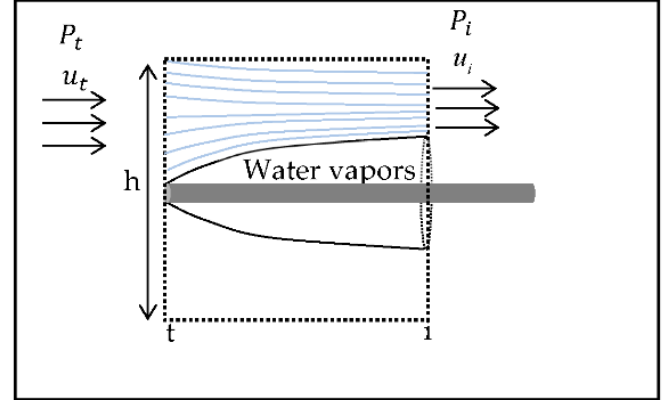
where P i , P t are the pressures in section i and t , correspondingly, g is the gravitational acceler- ation, ρ is the density of the water, and h is the height difference. As the height contribution is three orders of magnitude smaller than the dynamic pressure, ρ gh / 1 term in Equation (5) can be neglected.